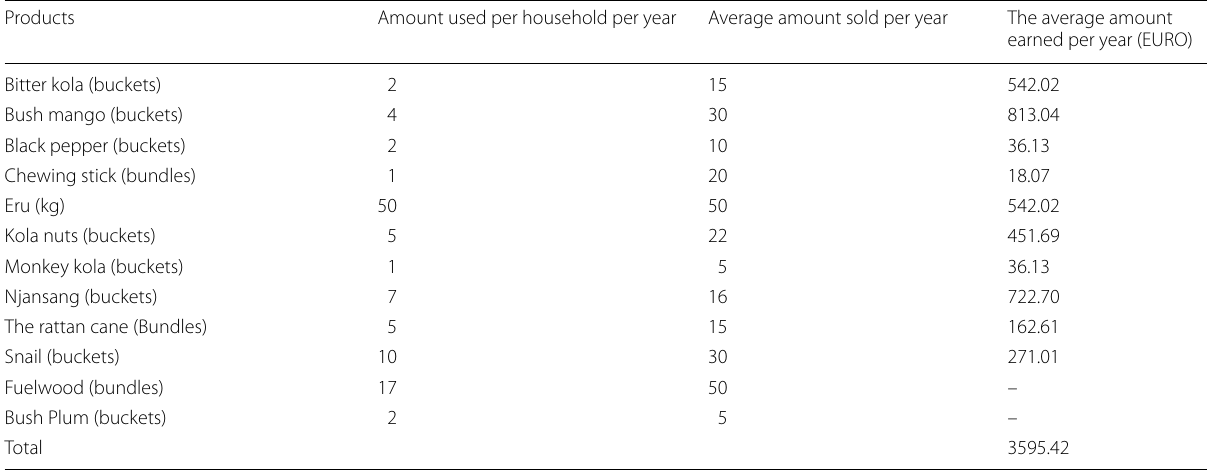
Table 3 NTFPs used and sold per household per year